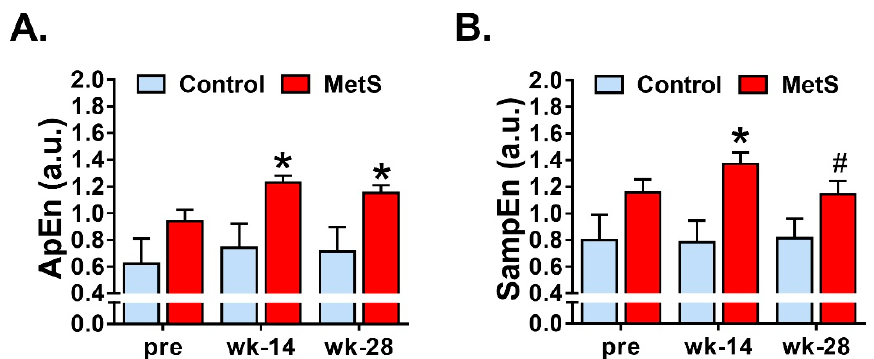
Figure 2. Nonlinear analysis of short-term HRV. Panel ( A ) shows changes in approximate entropy (ApEn). Sample entropy (SampEn) is displayed in panel ( B ) Control n = 9, MetS n = 13. * p < 0.05, # p = 0.07 vs. control. Error bars: SEM.